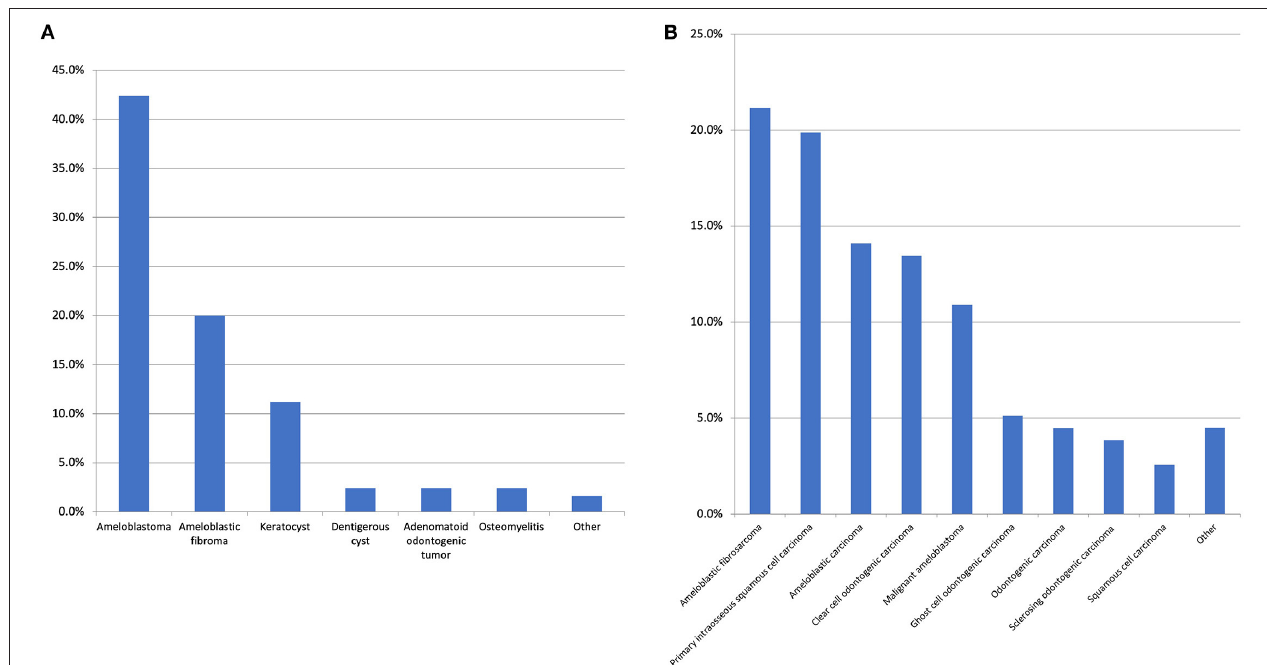
FIGURE 4 | (A) The most common benign first histological diagnosis. The “other” category includes unspecified odontogenic cyst, calcifying epithelial odontogenic tumour, cemento-ossifying fibroma, inflammation/infection post tooth-extraction, squamous odontogenic tumour, and pleomorphic adenoma with all with the same frequency (1.6%). There were 17 other diagnoses made with a range of conditions such as unspecified ameloblastic tumour and unspecified benign odontogenic cyst which were all reported at the same frequency (0.8%). (B) Top 10 most common second histological diagnosis. The “other” category includes ameloblastic fibro-odonto sarcoma, odontogenic carcinosarcoma (both 1.3%) and ameloblastic dentinosarcoma, malignant Pindborg tumour and calcifying epithelial odontogenic tumour (all 0.6%). It is of note, regarding the case of calcifying epithelial odontogenic tumour, one was diagnosed as a malignant variant and one case was diagnosed as a clear cell odontogenic carcinoma initially however this diagnosis was revised to the aforementioned on the resection.